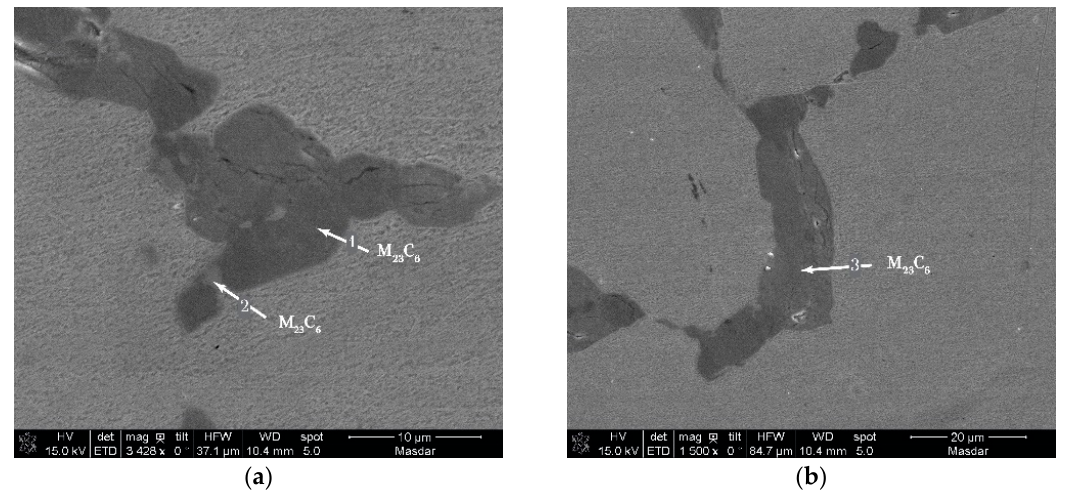
Figure 7. SEM images, ( a , b ), depicting coarse M 23 C 6 carbides in condition X. Numbers indicate EDX composition analysis in Table 2.